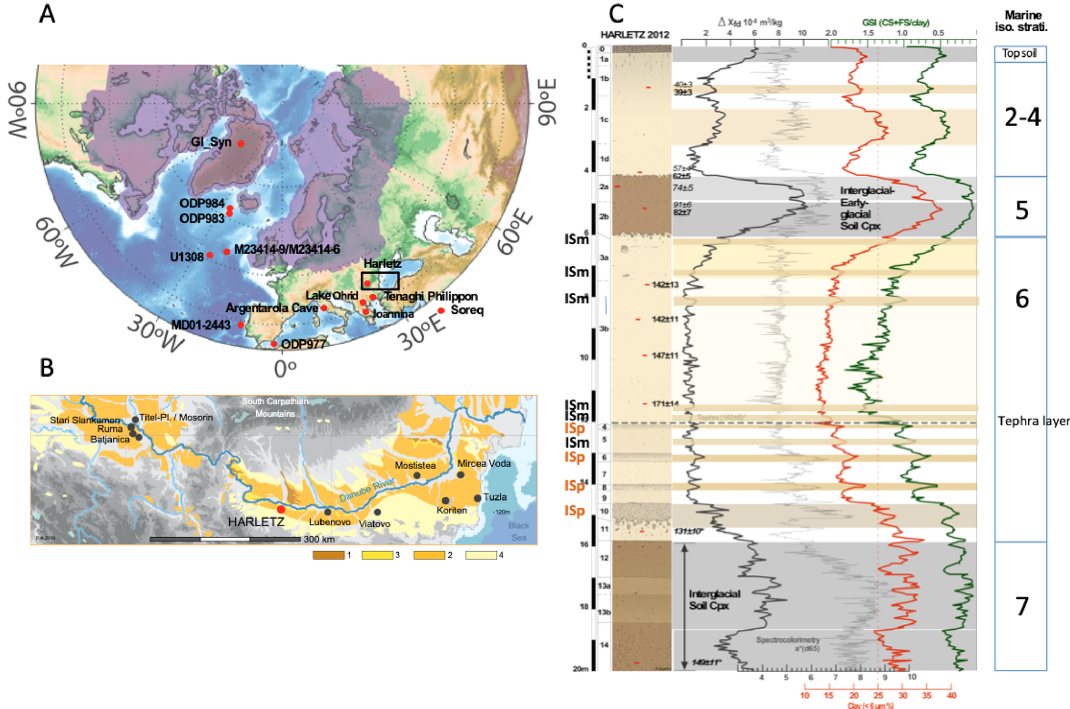
Figure 1. Harletz loess sequence. (a) Location of the western sites discussed in the text in the MIS 6 maximum ice sheet extent by Florence Colleoni from Dendy et al. (2017); the black box refers to (b) . (b) Location of Harletz loess sequence (red dot) in Bulgaria and nearby loess sequences (black dots) cited in the text (modified from Antoine et al., 2019; 1: eolian sands, 2: sandy loess, 3: loess > 5m, 4: loess < 5m). (c) Pedostratigraphy and variation of some parameters (grain size, magnetism, color reflectance; modified from Antoine et al., 2019). Interstadials deduced from the measured parameters (ISm) and corresponding to incipient weathered horizons and from paleosol observation (ISp) (this